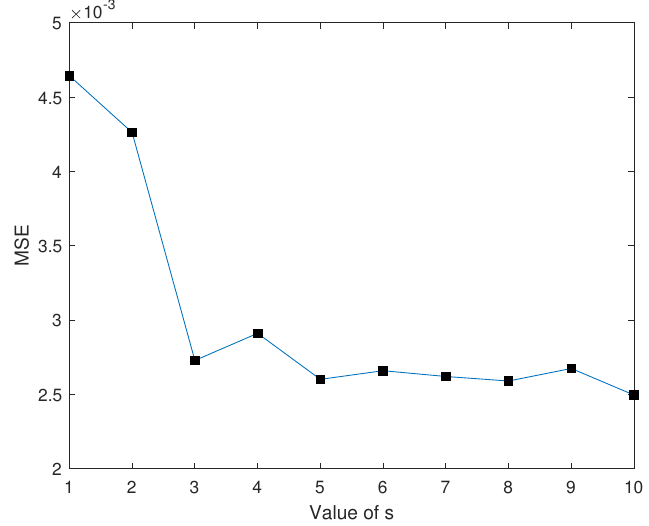
Figure 4. MSE with noisy data after 100 iterations.